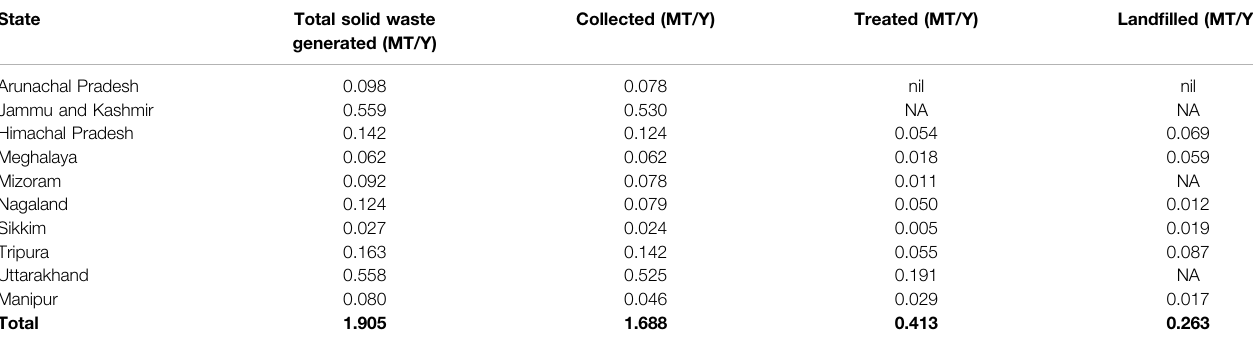
TABLE 1 | Status of total solid waste generation, collection, treatment, and land fi lled in the IHR states (Data Source: CPCB, 2019). A total of 1.905 MT/Y solid waste is generated, and out of which 1.688 MT/Y is collected, 0.413 MT/Y is treated, and 0.263 MT/Y is land fi lled in IHR. State Total solid waste Collected (MT/Y) Treated generated (MT/Y)